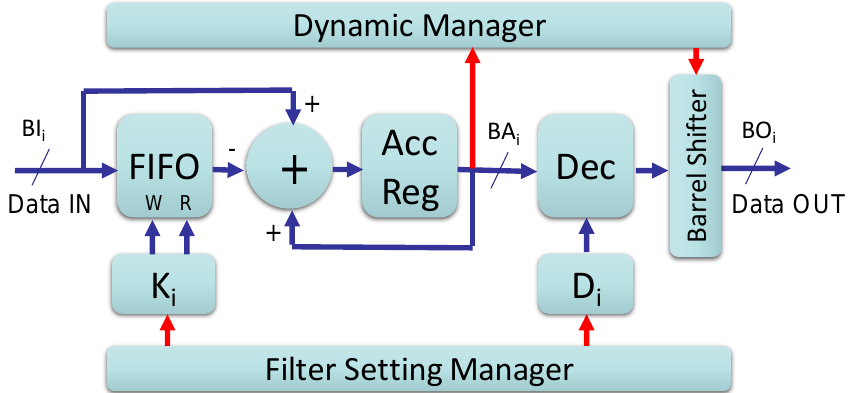
Figure 6. Details of the IC cell as implemented in the field programmable gate array (FPGA).